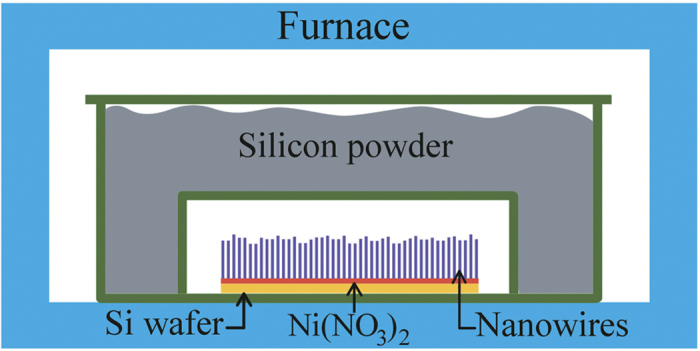
Schematic diagram of experimental setup for α-Si3N4 nanowires synthesis.